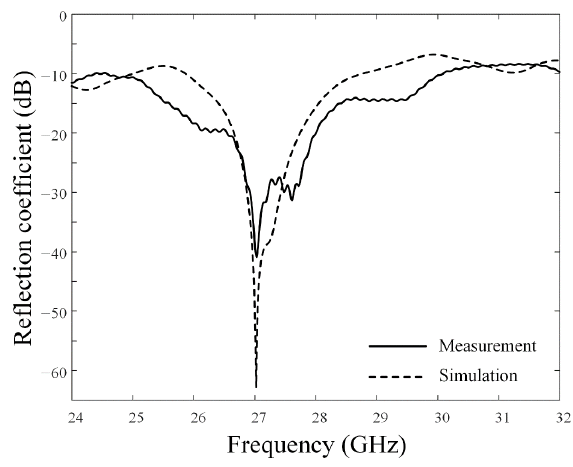
Figure 5. Reflection coefficient of the proposed antenna.